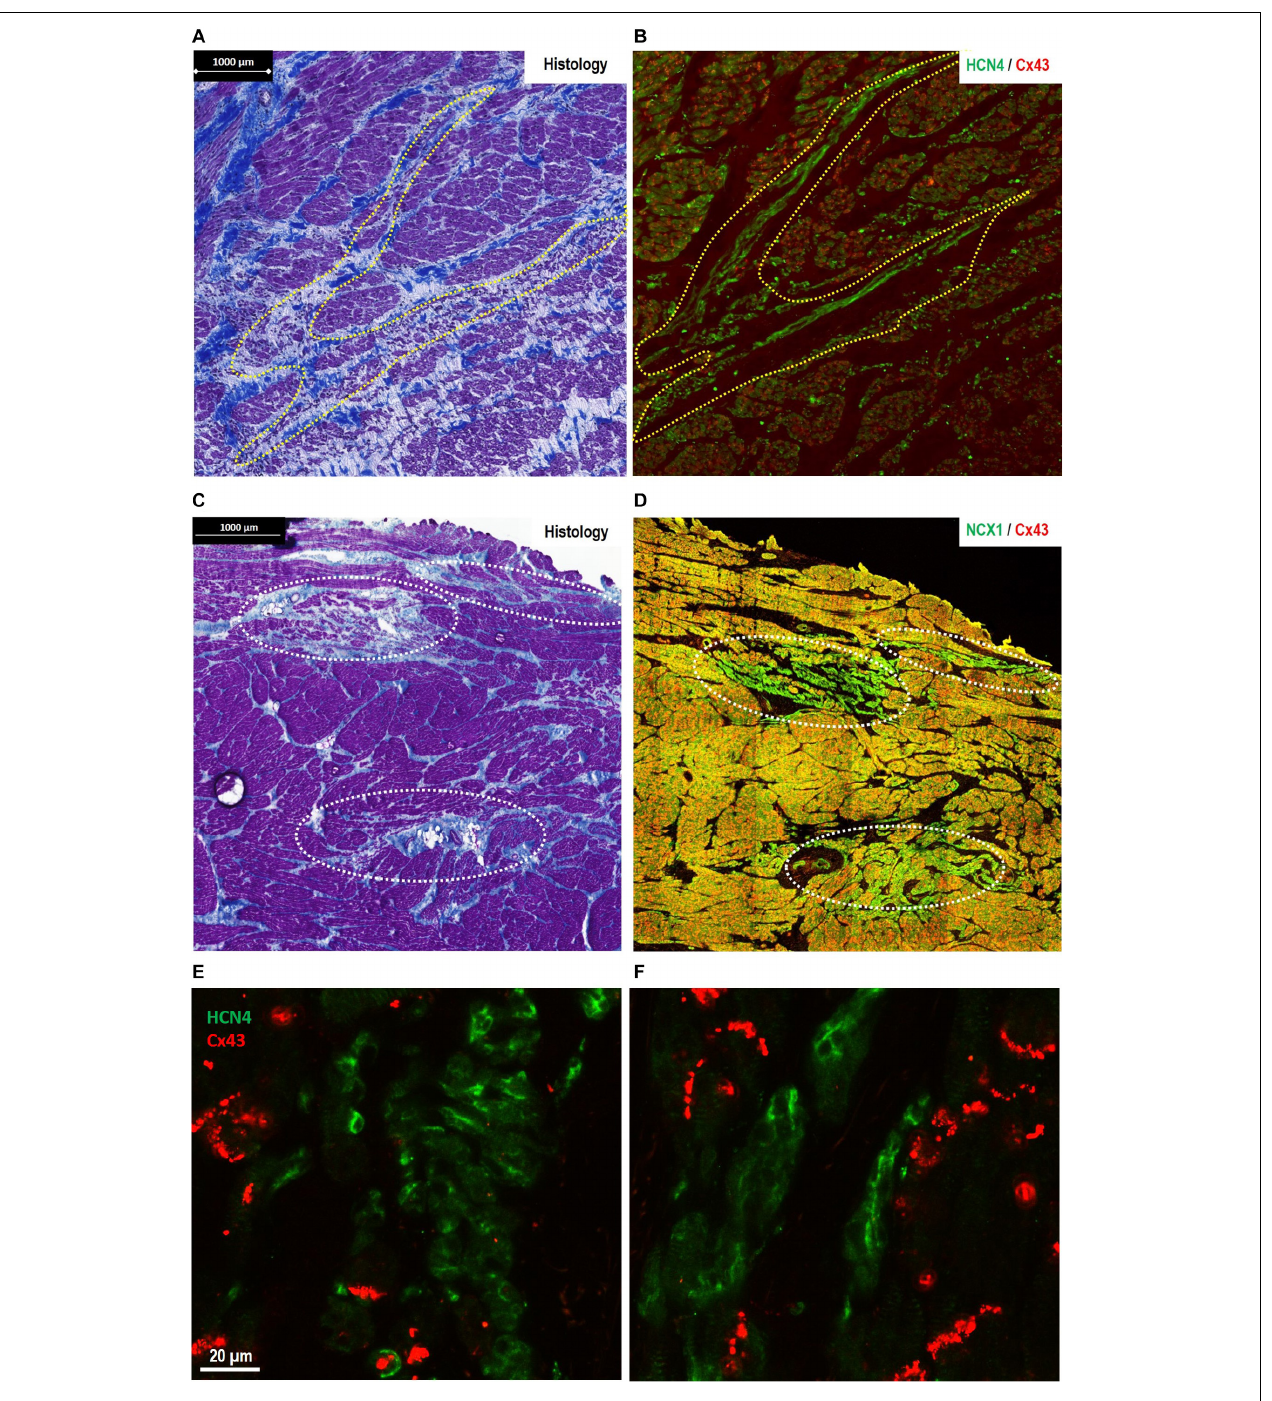
FIGURE 3 | Morphological features of pacemaker/sinus node (SAN)-like tissue in regions other than the primary SAN [where the site of earliest activation (SEA) is detected in healthy hearts]. (A,B) The finger-like projections of pacemaker-like tissue in the paranodal area (PNA)—“witch fingers.” (A) Histology (Masson’s trichrome) section of the PNA from a control goat (outlined in yellow, A). (B) Location of nodal-like cells are confirmed by immunofluorescence labeling of an adjacent section double labeled for Cx43 (red) and HCN4 (green). The nodal-like “witch” fingers in the PNA are predominantly HCN4 + /Cx43 - . (C,D) Islands of pacemaker-like cells within the subsidiary atrial pacemaker (SAP) regions—“lonely islands.” (C) Masson’s trichrome staining showed that cells with nodal-like phenotype in the SAP region formed well-defined islands in sections taken from the CT. (D) These “lonely islands” are confirmed to have “nodal”-like phenotype by IF labeling of an adjacent section Cx43 (red) and NCX1 (green). The nodal-like island SAP are predominantly NCX1 + /Cx43 − . Corresponding high-power images of sections stained for HCN4/Cx43 are shown for SAP islands in panel (E) and “witch fingers” in panel (F) demonstrating clusters of HCN4 + /Cx43 − pacemaker-like cells (green) among the Cx43 + atrial myocytes